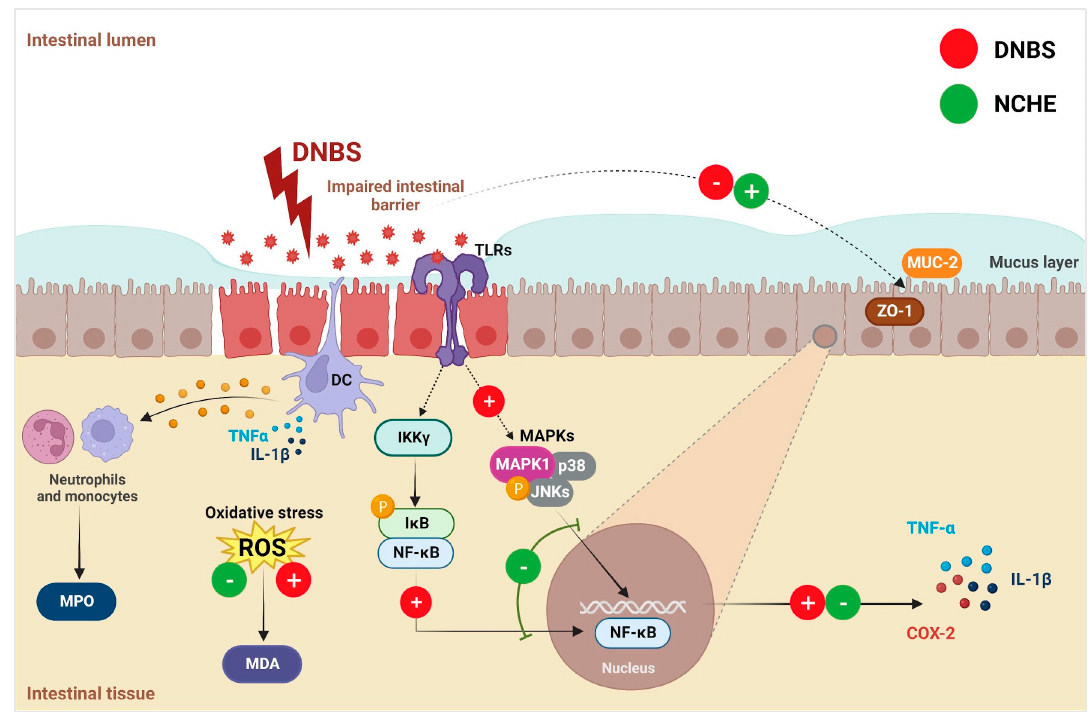
Figure 9. Schematic representation of the proposed mechanisms of action of dinitrobenzene sulfonic acid (DNBS) and Nopalea cochenillifera hydroethanolic extract (NCHE) in DNBS-induced colitis. NCHE inhibits the activation of nuclear factor kappa B (NF- κ B) and mitogen activated protein kinase 1 (MAPK1) signaling pathways induced by DNBS. The suppression of the translocation of NF- κ B to the nucleus can also be a possible reason for reduced levels of cyclooxygenase-2 (COX-2), interleukin-1 beta (IL-1 β ) and tumor necrosis factor-alpha (TNF- α ). Through recognition of Pathogen Associated Molecular Patterns (PAMPs) by toll-like receptors (TLRs), gastric mucosal epithelial cells, through signal transduction pathways, can attract neutrophils and dendritic cells, favoring the production of inflammatory cytokines (IL-1 β and TNF- α ). It is suggested that NCHE may act by reducing neutrophil chemotaxis and neutralizing reactive oxygen species (ROS) produced by DNBS inflammation, decreasing myeloperoxidase (MPO) and malondialdehyde (MDA) levels in the tissue, respectively. NCHE can also improve DNBS-induced intestinal barrier dysfunction through positive regulation of mucin type 2 (MUC-2) and tight junction protein zonula occludens-1 (ZO-1) expression.